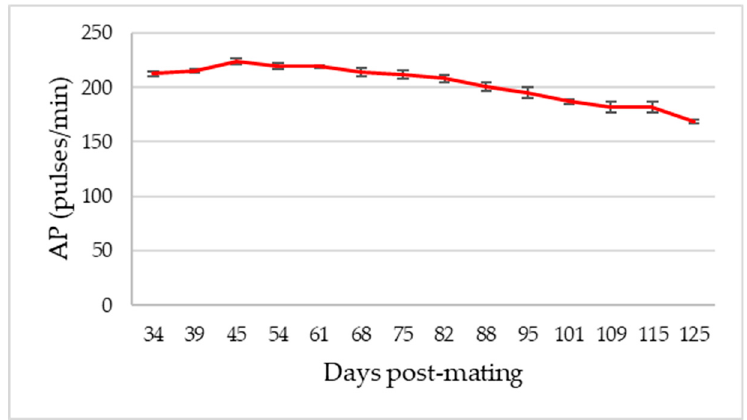
Figure 4. Evolution curve of Arterial Pulse (AP) in total goats under study ( n : 9). The mean and the standard deviation of the measurements are plotted in relation to the days after mating.